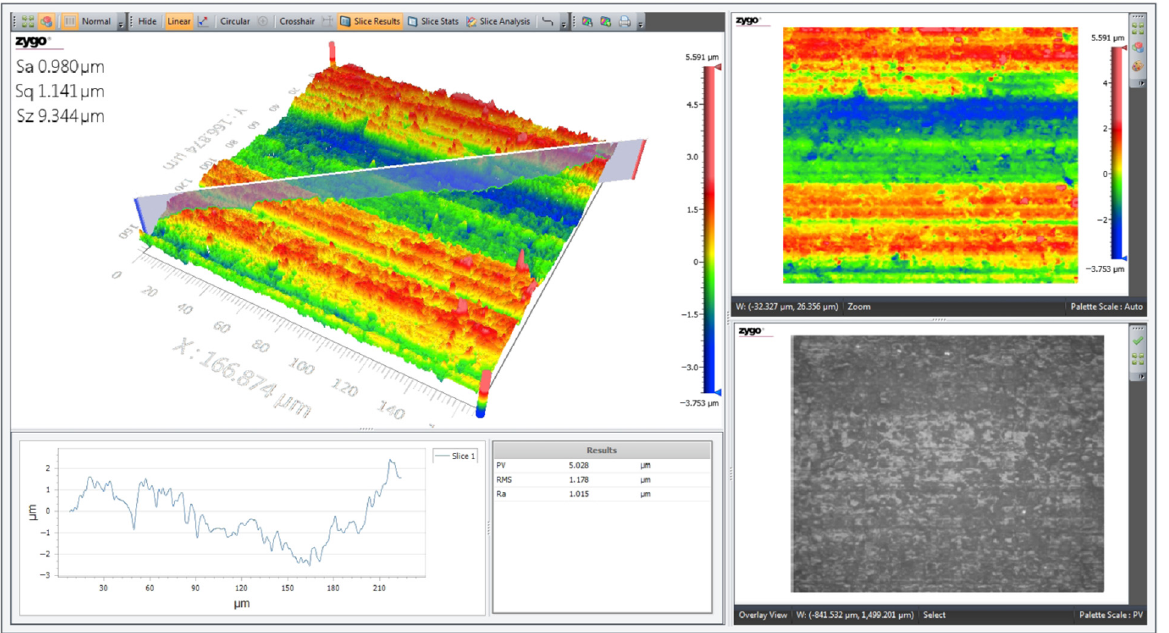
Figure 4. The 3D surface profile of Al 0.5 Sb 0.5 FeO 3 multiferroic perovskite.